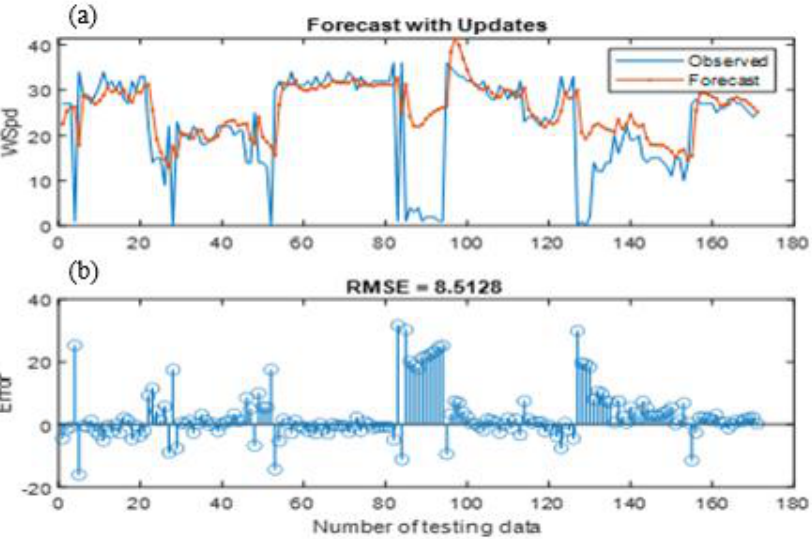
Figure 6. Wind speed prediction of the proposed LSTM for Spring (March 2015) data: ( a ) Comparison of observed values and forecast values; ( b ) Error and RMSE value values.